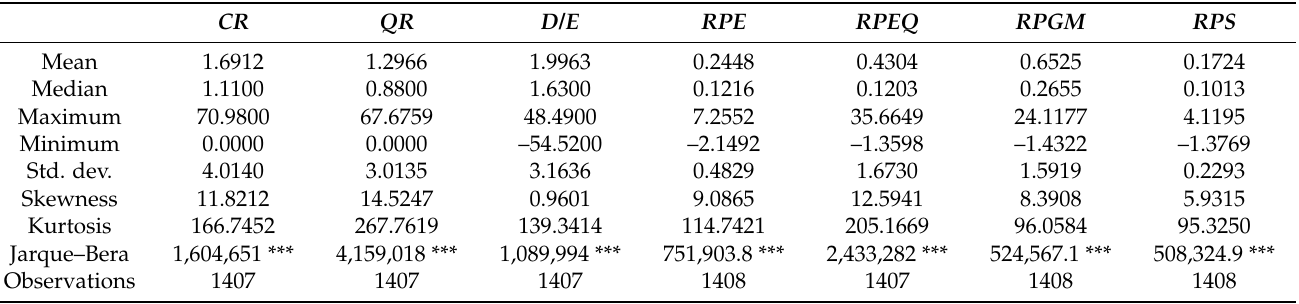
Table 4. Descriptive statistics for all companies.